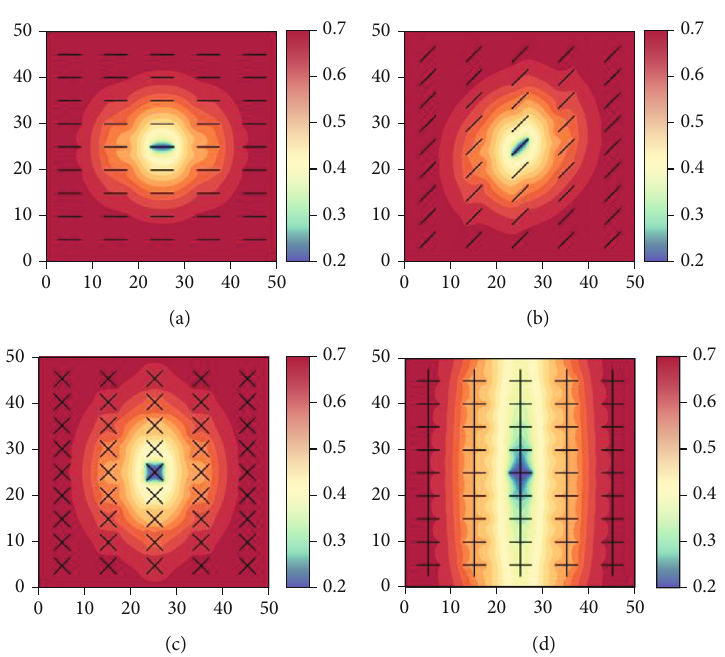
Figure 8: Spatial distribution of water saturation after 100 days of production for di ff erent fracture